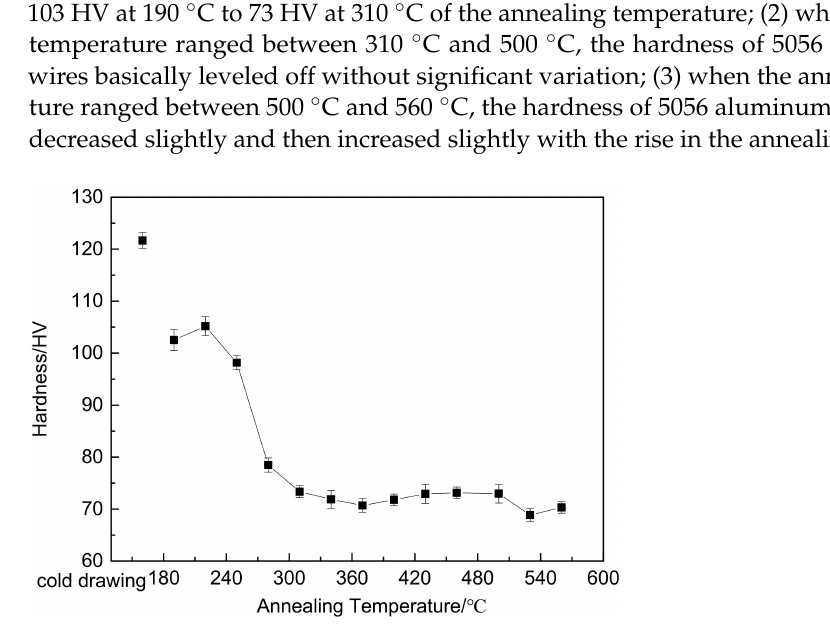
Figure 7. Vickers hardness of a cold-drawn 5056 aluminum alloy after annealing at different